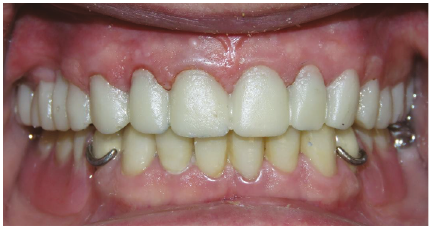
Figure 7: Maxillary temporary